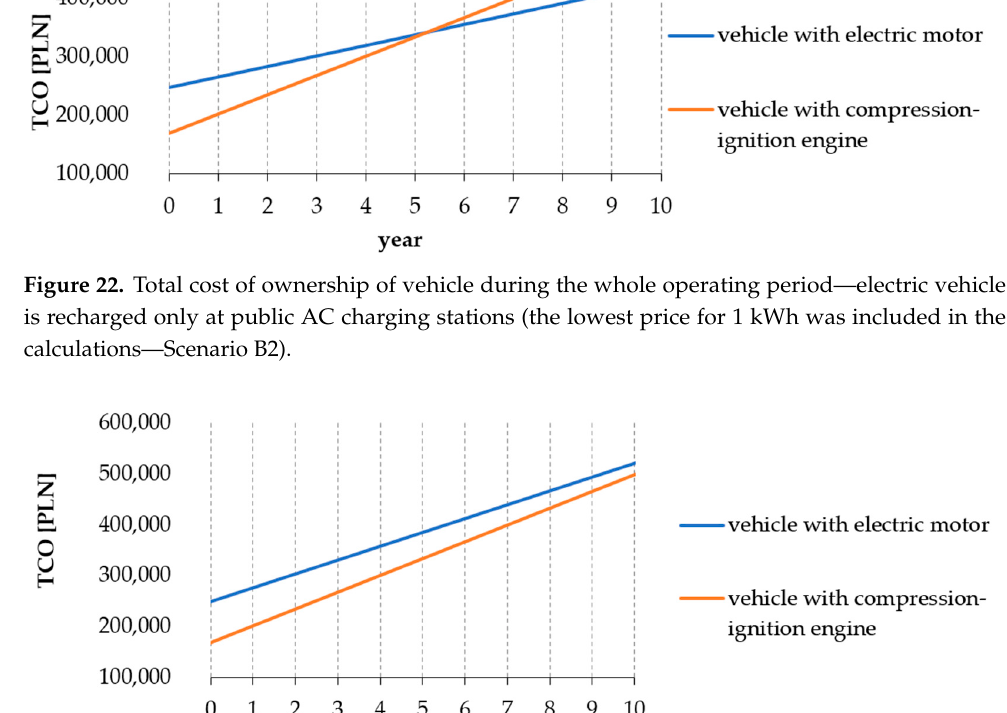
Figure 23. Total cost of ownership of vehicle during the whole operating period—electric vehicle is recharged only at public AC charging stations (the highest price for 1 kWh was included in the calculations—Scenario B3).